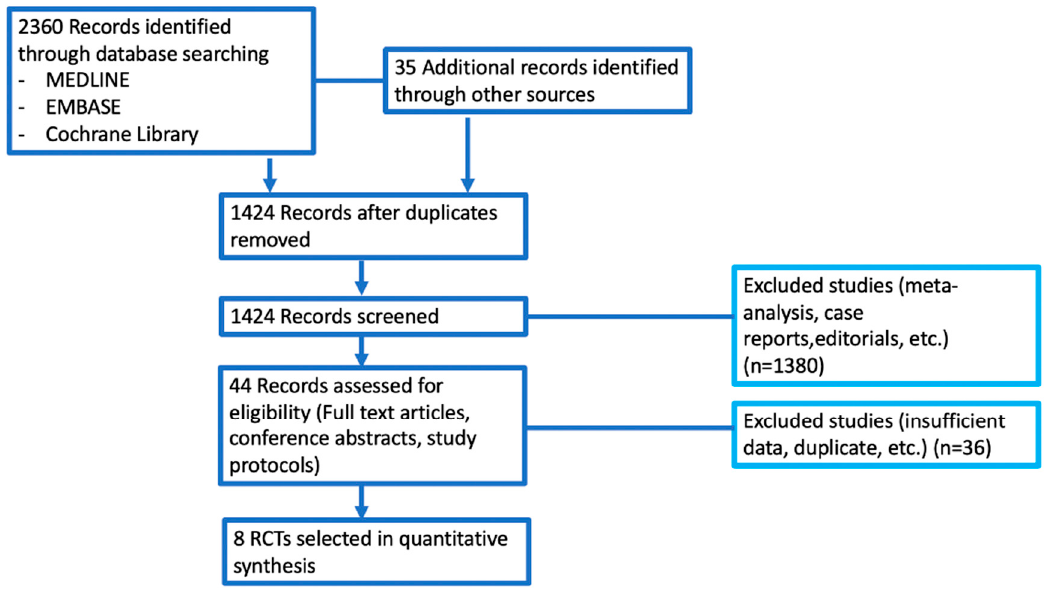
Figure 2. Figure reporting all the trials included and excluded in the quantitative synthesis. Table 1. Summary of the included studies. Abbreviations: RFS: recurrence-free survival; HR: hazard ratio; CI: confidence interval; and ITT: